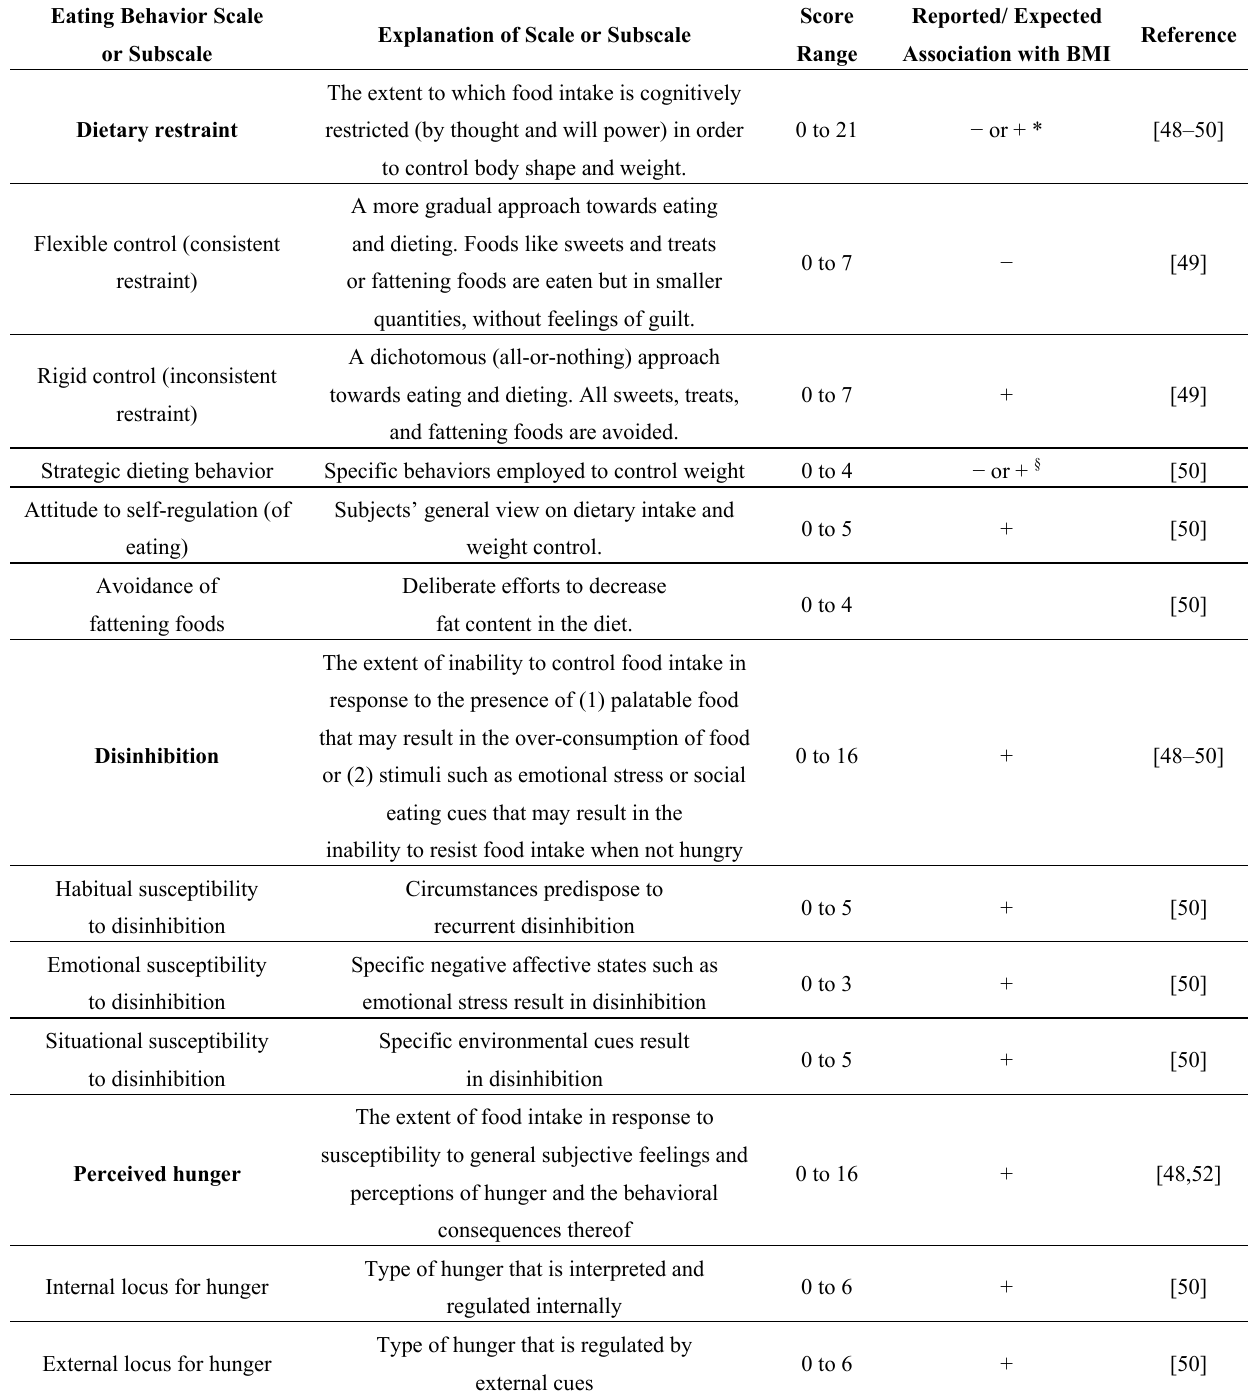
Table 1. Summary, explanation, score range, and reported association with body mass index (BMI) of the scales and subscales of the three-factor eating